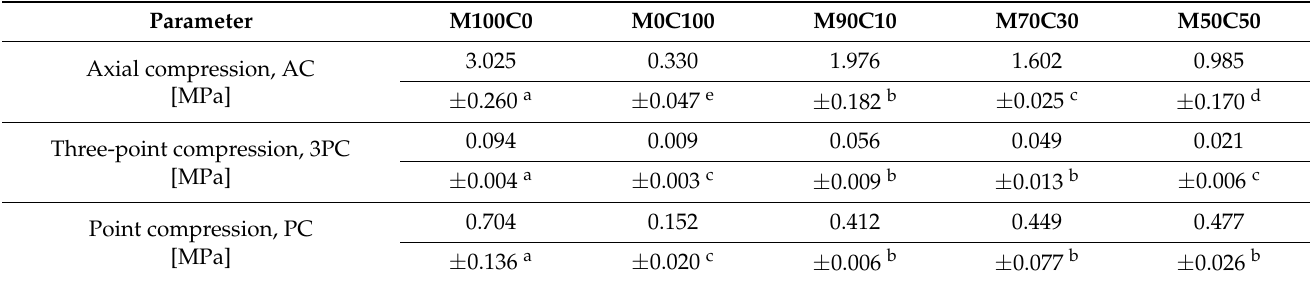
Table 3. Results of the mechanical strength tests for pellets of various blends.